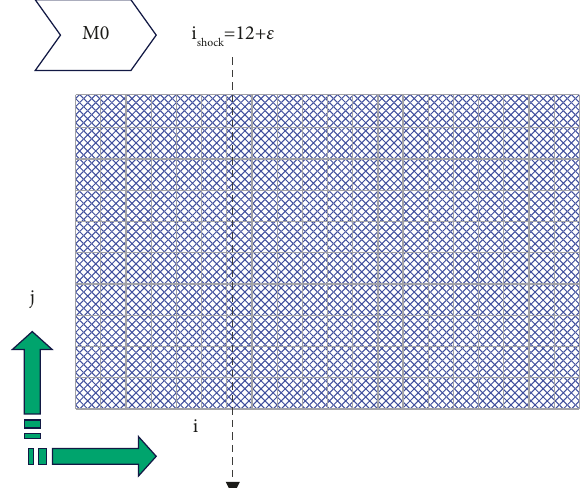
Figure 2: Computational grid and initial conditions for the quasi- one-dimensional (1.5D) steady-state animation frame